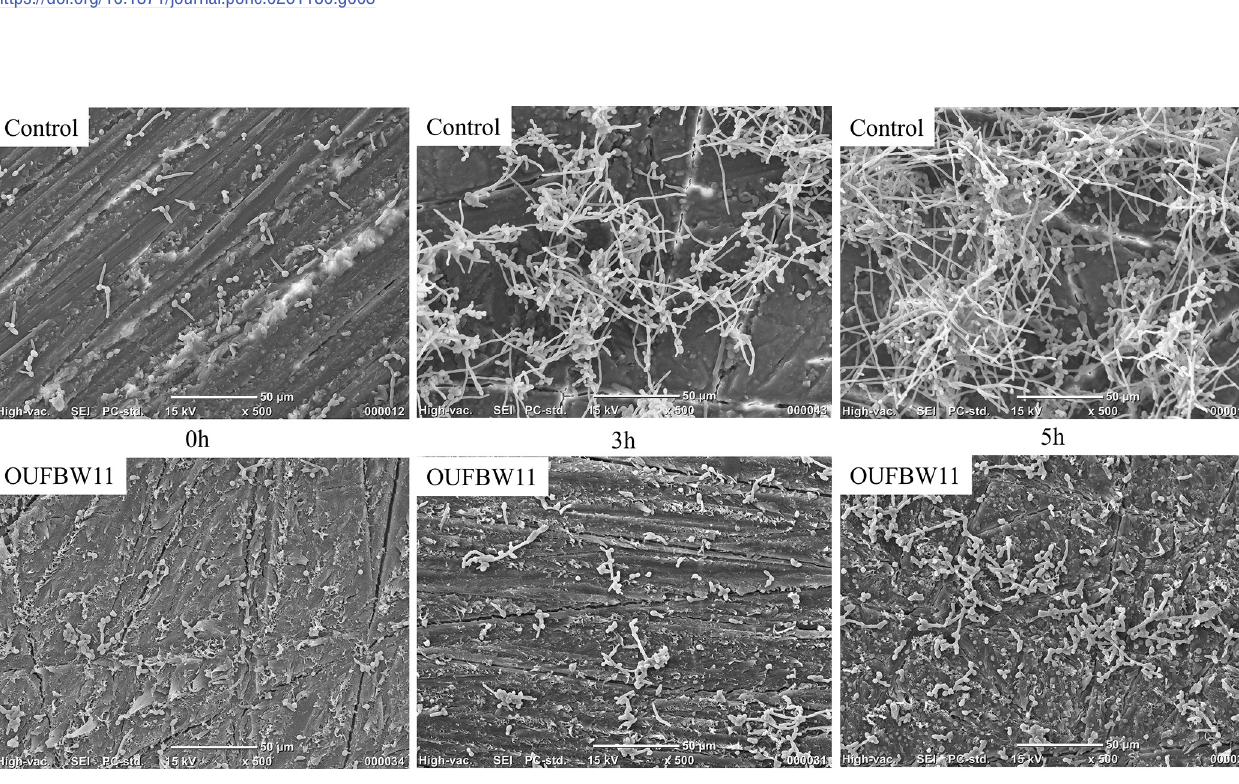
PLOS ONE | https://doi.org/10.1371/journal.pone.0261180 December10, 2021 8 /